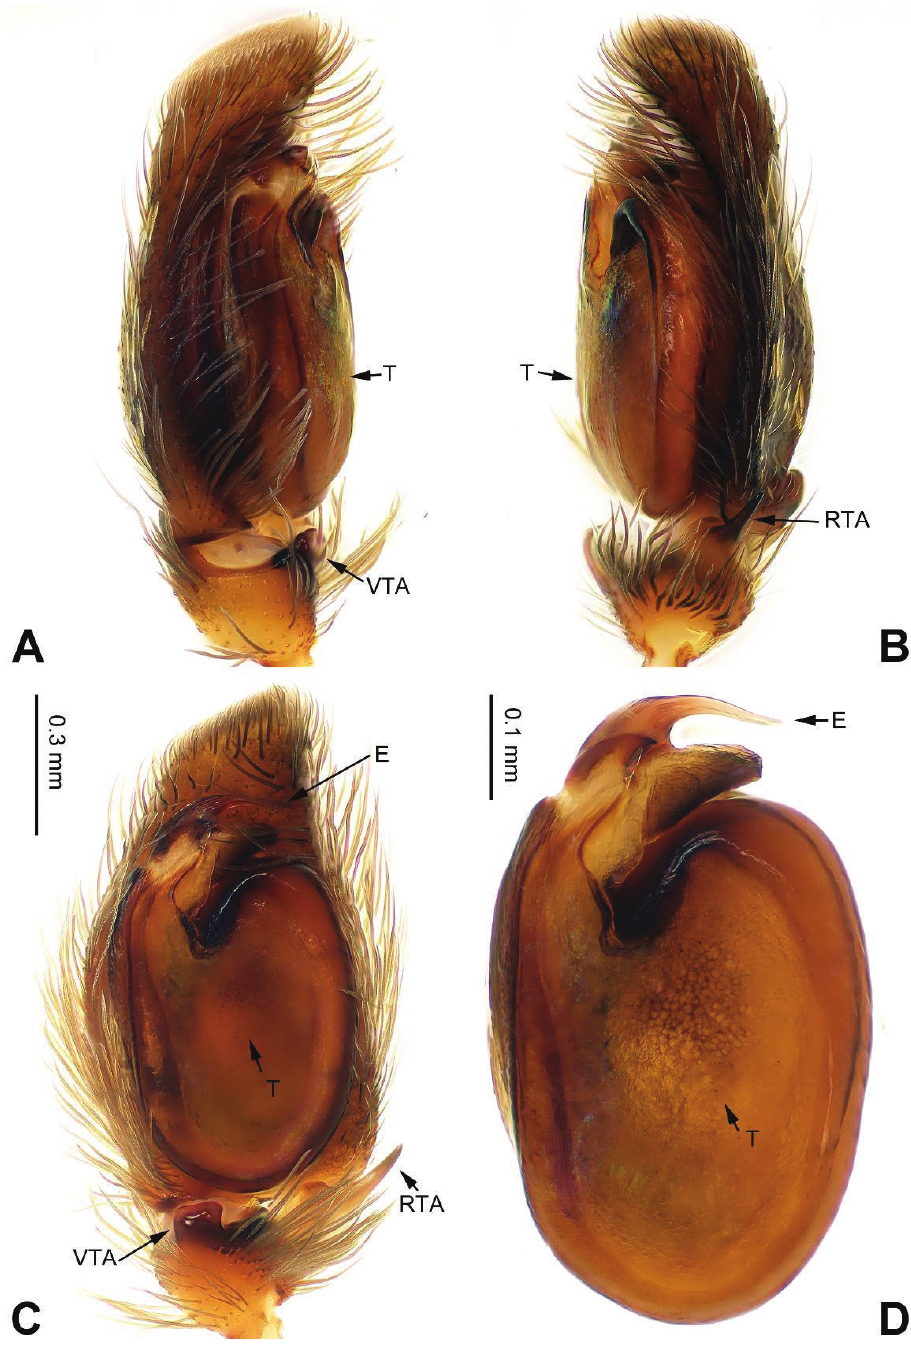
Figure 24. Palp of Gelotia zhengi sp. n., male holotype. A prolateral B retrolateral C ventral D bulb, ventral. Scale bar equal for A–C